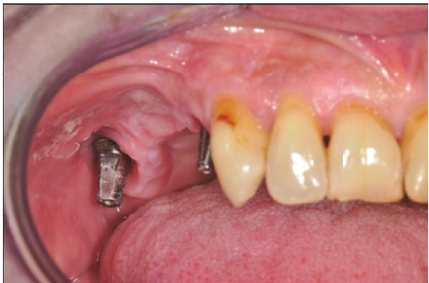
Figure 2: Preoperative clinical view of right posterior maxilla after the prosthesis was removed. The dental implant sited in position 1.6 results missed due to its dislocation into the sinus